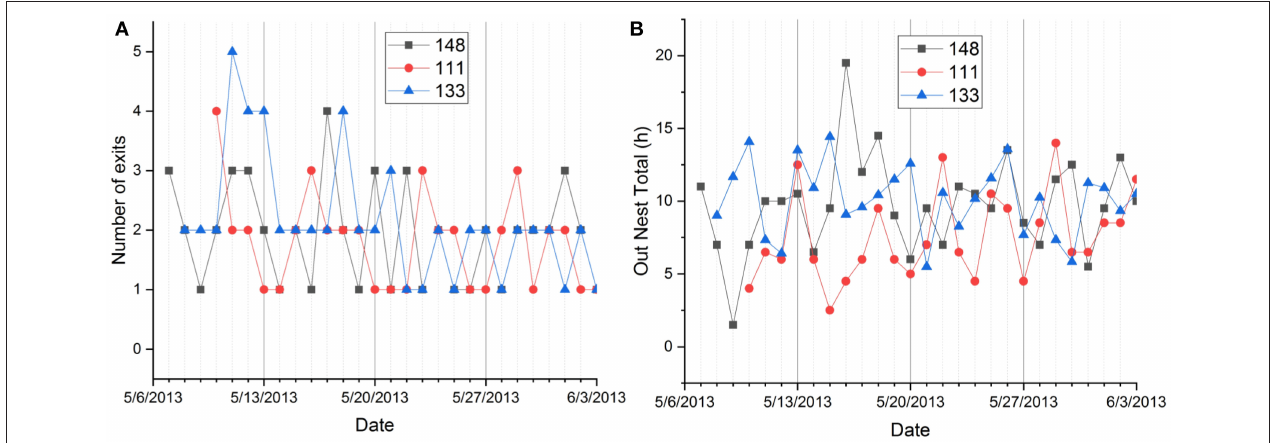
FIGURE 5 | Day-to-day fluctuation of nest exits (A) and total out-of-nest time (B) in individual squirrels recorded during the same 28 days in spring and summer.